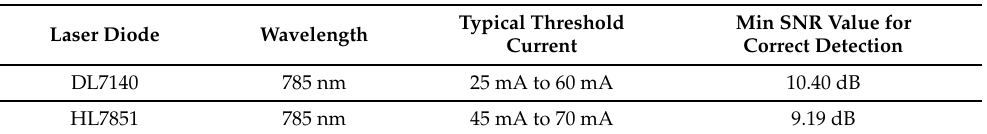
Table 3. Typical values of commercial laser diodes used for performance analysis of signals obtained as function of